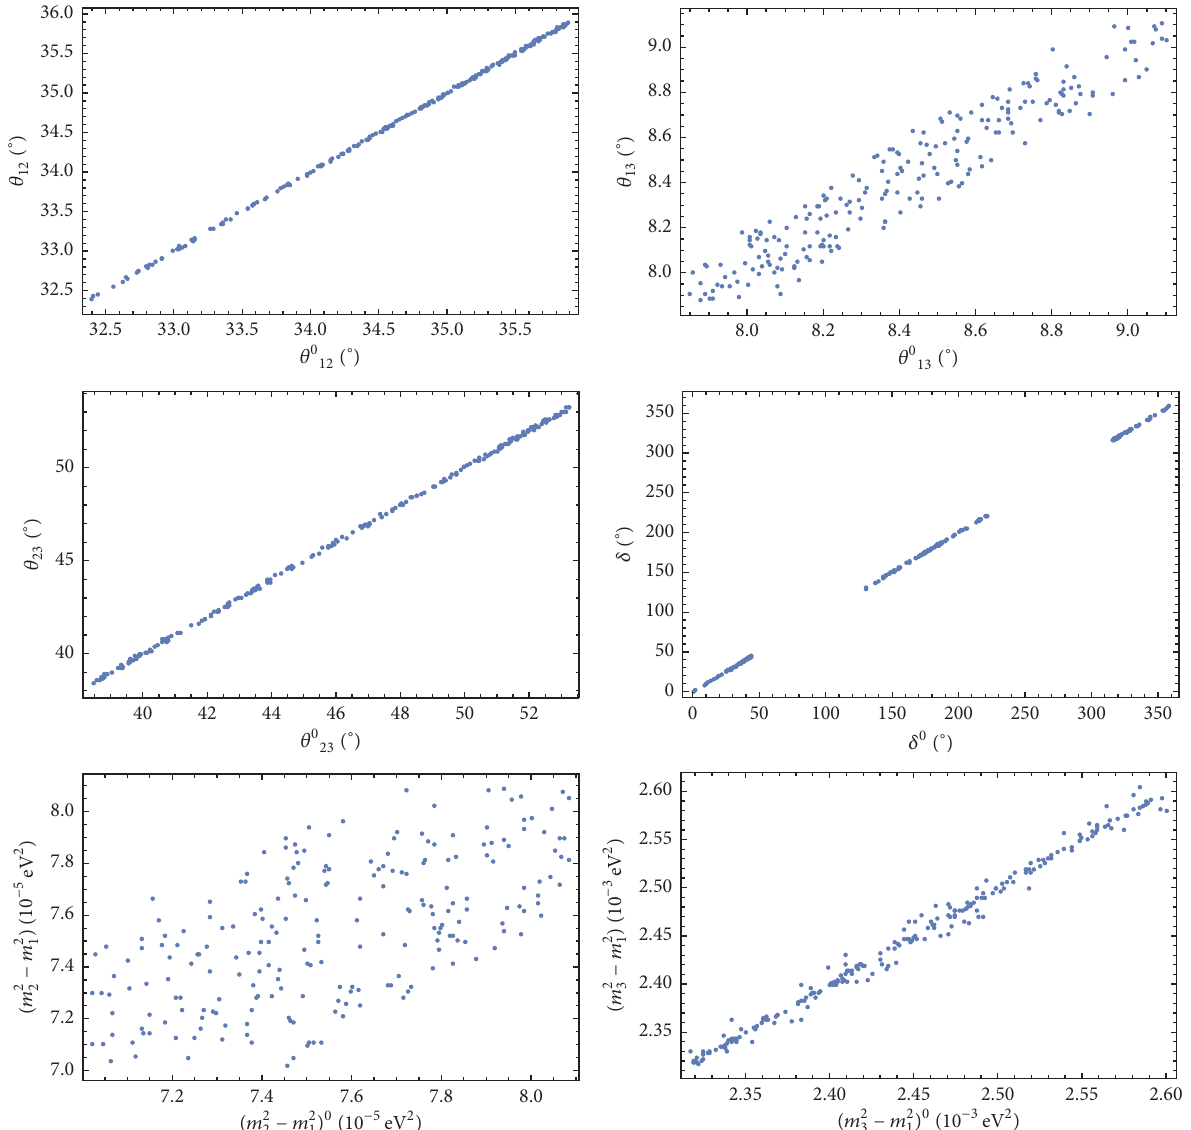
Figure 2: Correlations of neutrinos oscillation parameters before and after the perturbation with the parameter 𝜖 0 . Here the superscripts “0” in the plots denote original oscillation parameters (before perturbations). The original mixing parameters are at 3 𝜎 level from [21].